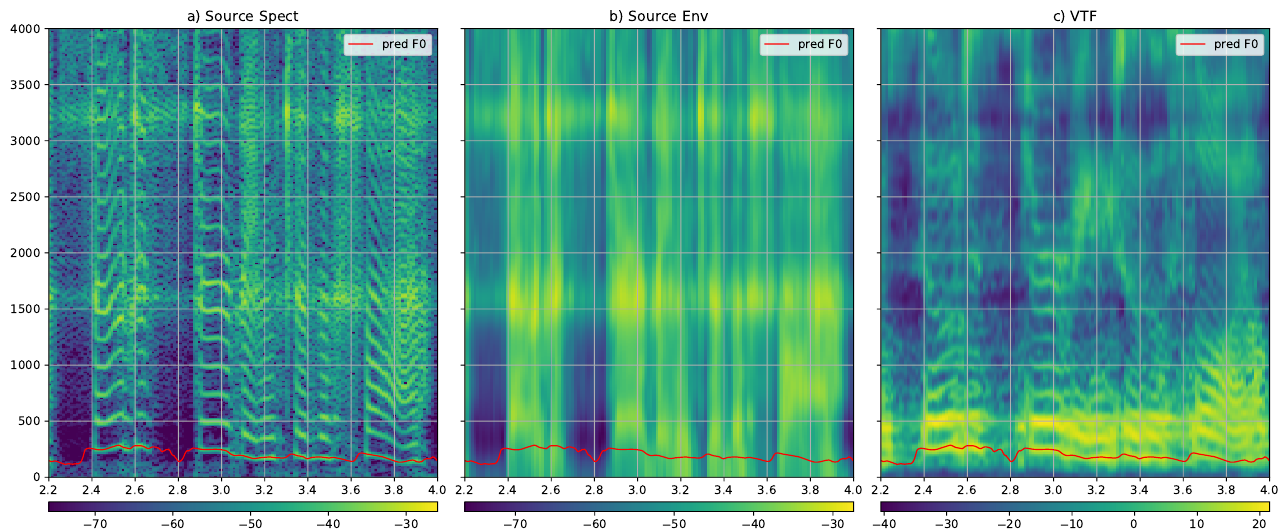
Figure A1. Visualization of the source filter components generated by the MBExWN model. The red line visible in all figures is the F 0 predicted by the F 0 component. ( a ) The spectrogram of the source signal generated by the PostNet. ( b ) The estimate of the spectral envelope of the source signal. ( c ) The VTF generated in the VTF model of the MBExWN model. Another observation that can be made in Figure A1 is the fact that the periodic attenuation/amplification linked to the PWMF filter does not seem to be present at all time positions. The amplification of the source signal seems to be weaker at 3200 Hz and time position 3.8 s and correspondingly the attenuation is weaker in the VTF at the same location. We see this coherent modification of the source signal and the VTF as a positive result that indicates that the coupling of source and filter is working correctly, even if here the model does use it to fix a problem that is produced by the PQMF component. We note that the periodic amplification could be easily prevented by means of a constant filter, but this optimization did not seem justified given the model handles this rather stable effect quite